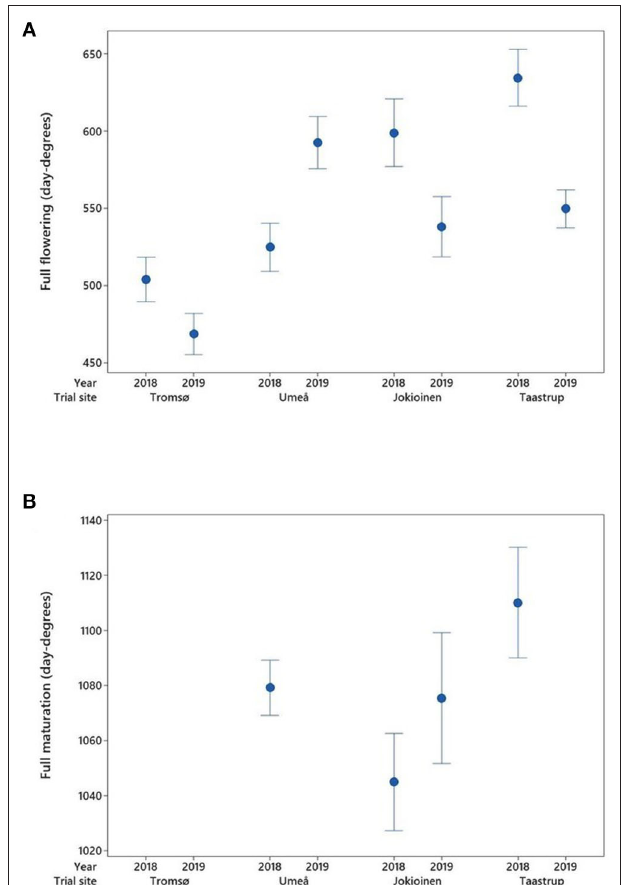
FIGURE 3 | Average day-degree sums at different sites and years for the development of (A) full flowering and (B) full maturation in ( n = 49–52) accessions, with error bars indicating a 95% confidence interval. There was no development of mature pods in Tromsø in either year or in Umeå in 2019. The data for full maturation were not recorded and are therefore missing at Taastrup for the year